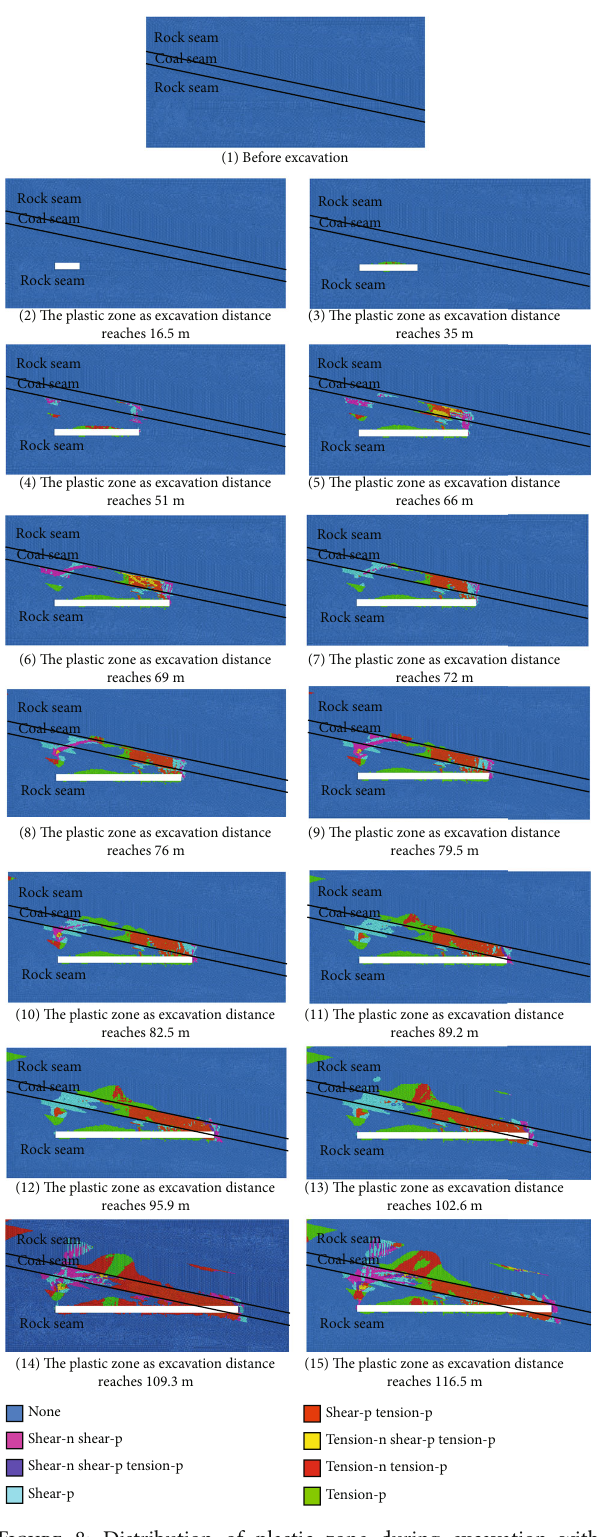
Figure 8: Distribution of plastic zone during excavation with coe ffi cient of lateral pressure of